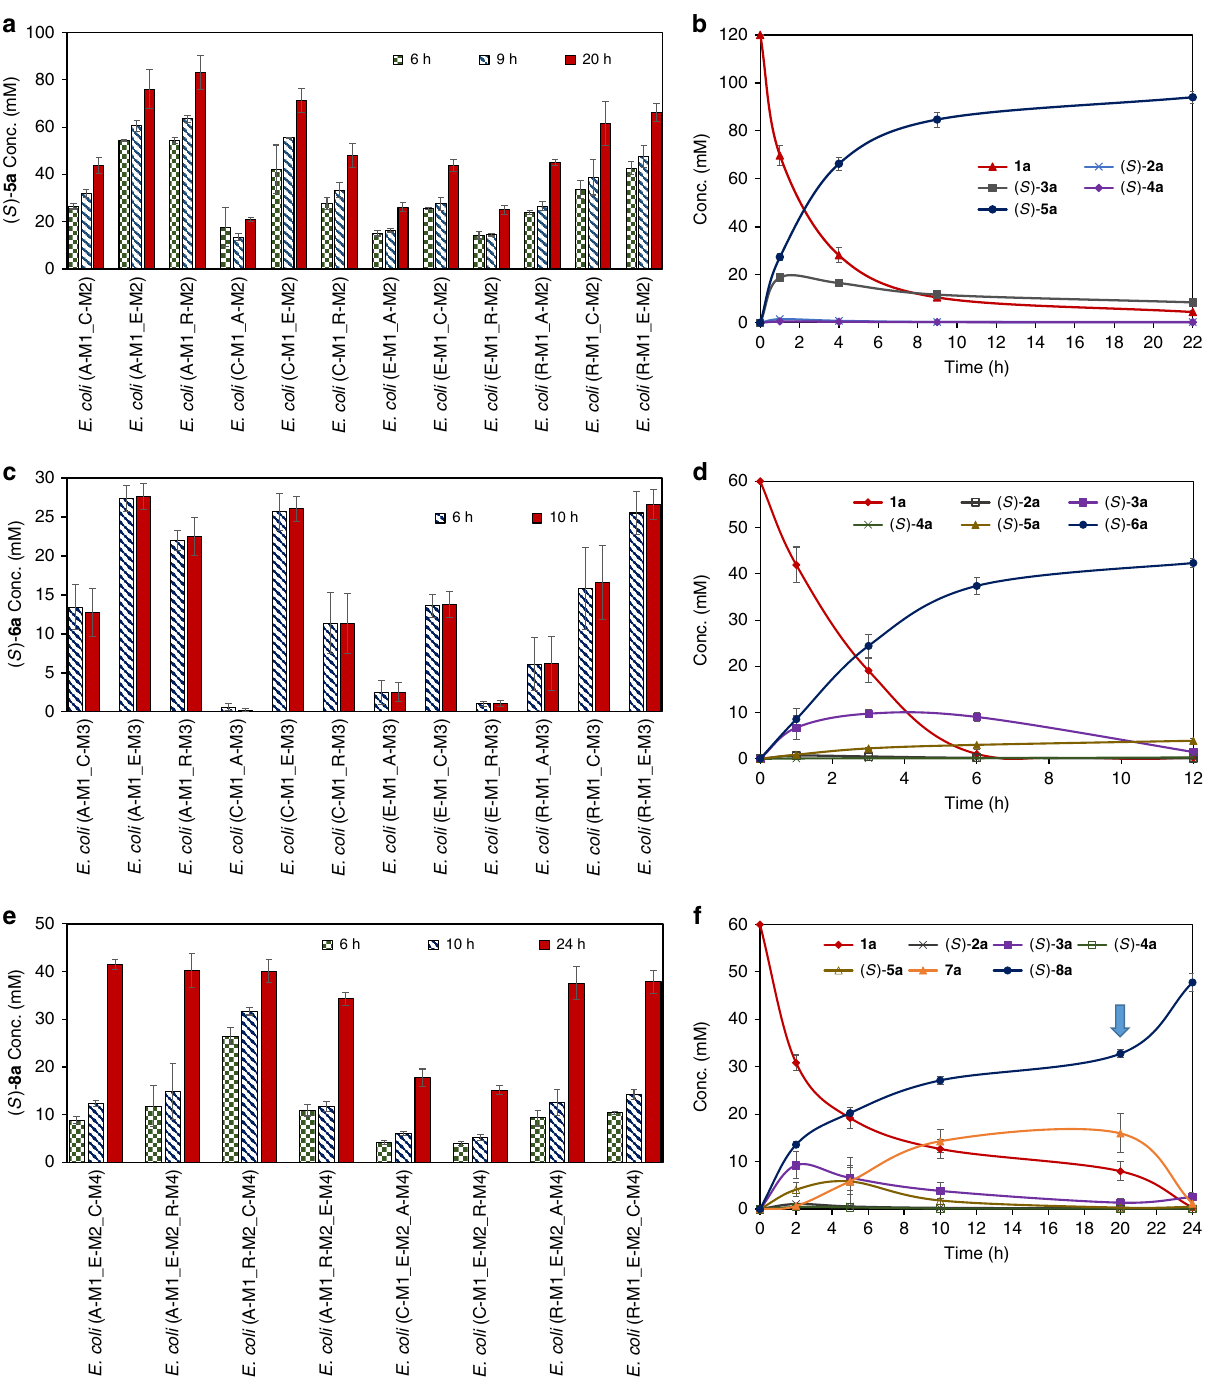
Figure 4 | Regio- and enantioselective multiple oxy- and amino-functionalizations of styrene 1a with E. coli strains containing multiple enzyme modules. ( a ) Product concentration of biotransformation of 100mM 1a to ( S )- 5a with twelve E. coli strains (10gcdwl (cid:2) 1 ), each containing both enzyme module 1 and 2, respectively. ( b ) Time course of biotransformation of 120mM 1a to ( S )- 5a with E. coli (A-M1_R-M2) cells (15gcdwl (cid:2) 1 ) in a two-liquid-phase system (KP buffer containing 0.25% glucose and n -hexadecane; 1:1) at 30 (cid:2) C. ( c ) Product concentration of biotransformation of 50mM 1a to ( S )- 6a with twelve E. coli strains (10gcdwl (cid:2) 1 ), each containing both enzyme module 1 and 3, respectively. ( d ) Time course of biotransformation of 60mM 1a to ( S )- 6a with E. coli (A-M1_E-M3) cells (15gcdwl (cid:2) 1 ) in a two-liquid-phase system (NaP buffer containing 1% glucose and 200mM NH 3 /NH 4 Cl and n -hexadecane; 1:1) at 25 (cid:2) C. ( e ) Product concentration of biotransformation of 50mM 1a to ( S )- 8a with eight E. coli strains (10gcdwl (cid:2) 1 ), each containing enzyme module 1, 2 and 4, respectively. ( f ) Time course of biotransformation of 60mM 1a to ( S )- 8a with E. coli (A-M1_R-M2_C-M4) cells (15gcdwl (cid:2) 1 ) in a two-liquid-phase system (KP buffer containing 0.5% glucose and 100mM NH 3 /NH 4 Cl and n -hexadecane; 1:1) at 30 (cid:2) C (arrow: adding additional 0.5% glucose and 100mM NH 3 /NH 4 Cl at 20h). All biotransformations were performed in triplicate, and error bars show ±